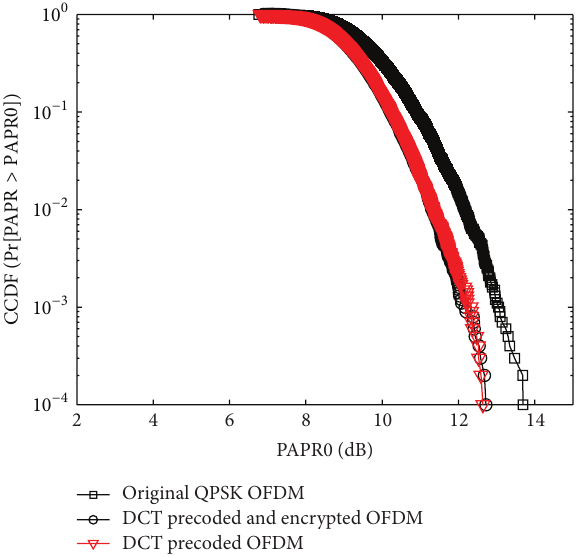
Figure 8: Comparison of the PAPRs of the precoded 16 QAM OFDM signals with and without chaos scrambling.